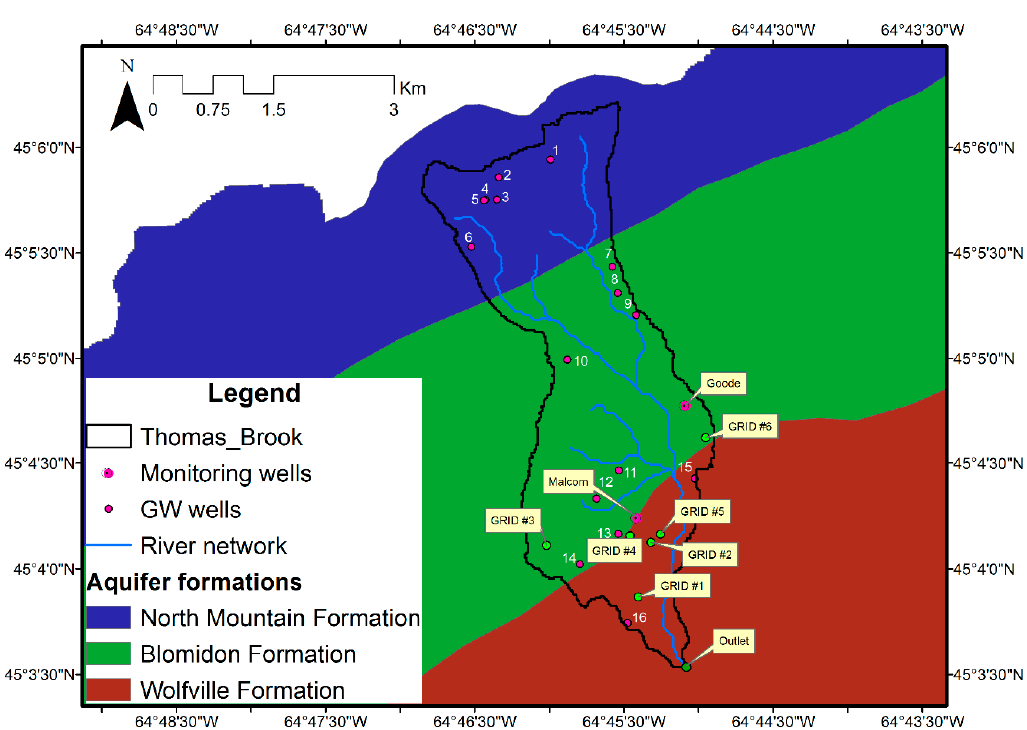
Figure 2. Aquifer formations along with the location of groundwater wells in the Thomas Brook catchment (modified after [17]).